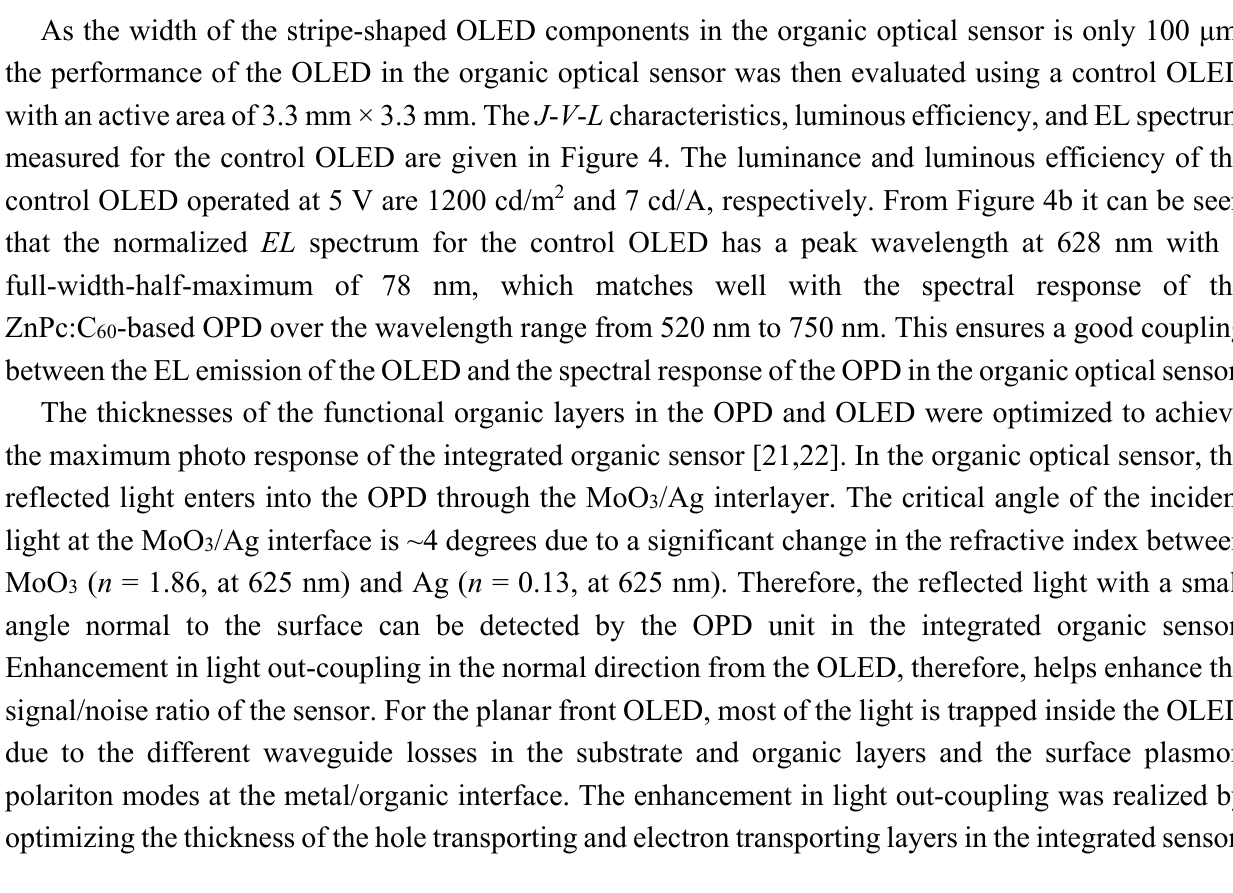
Figure 3. J-V characteristics measured for the control OPD and the OPD in the integrated organic optical